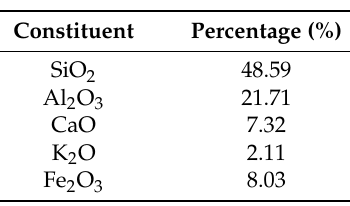
Table 2. Chemical composition of fly ash R (FAR).